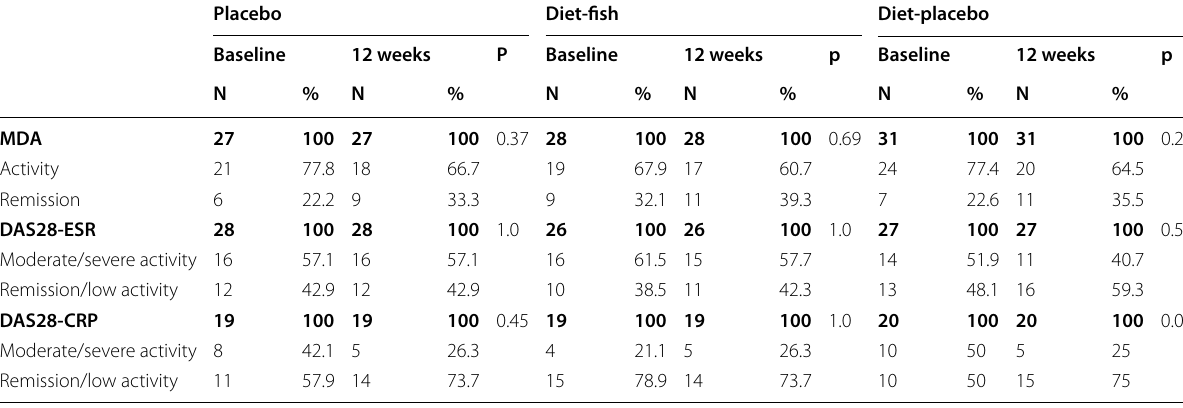
Bold indicates p statistically significant (